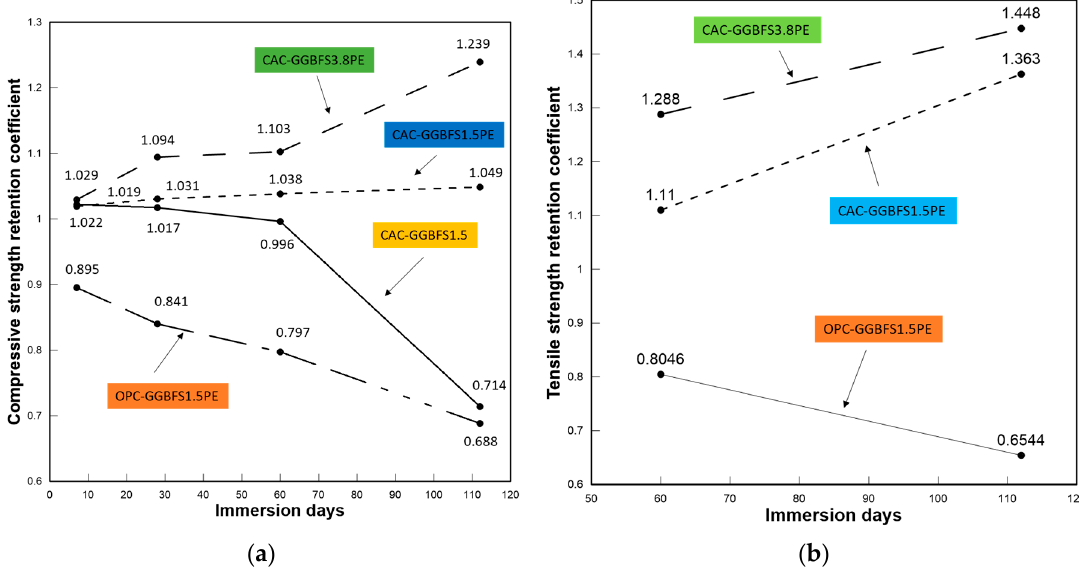
Figure 14. Sulfuric acid resistance of all mixtures. ( a ) Compressive stress. ( b ) Ultimate tensile stress.